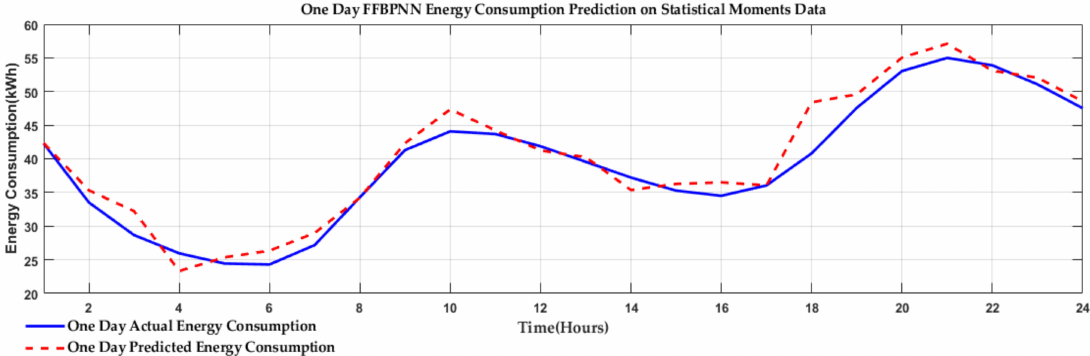
Figure 17. One day hourly energy consumption prediction using FFBPNN on statistical moments data.